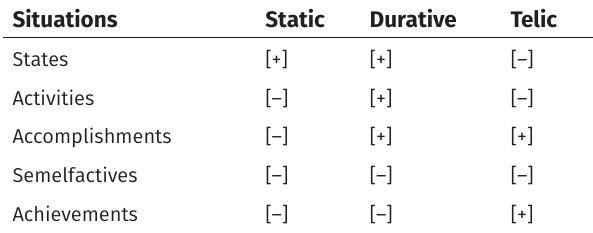
Table 2: Features of verb types based on Smith (1997: